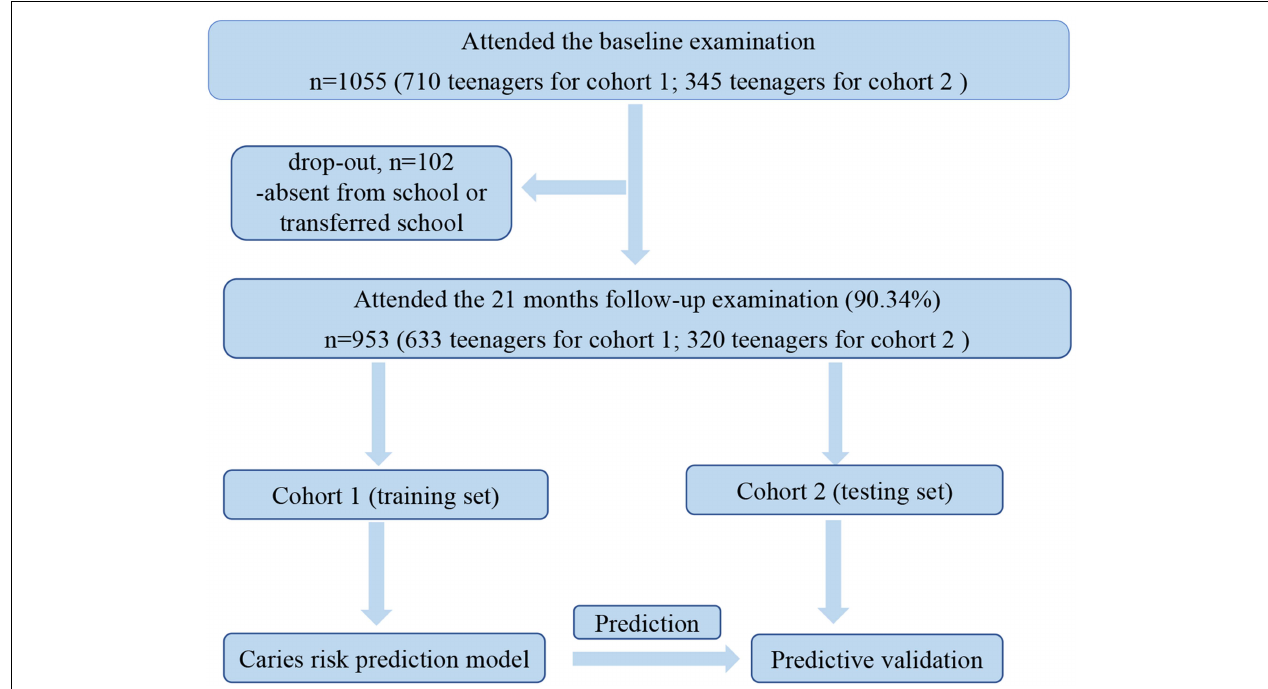
FIGURE 1 | Flow chart of the prospective longitudinal